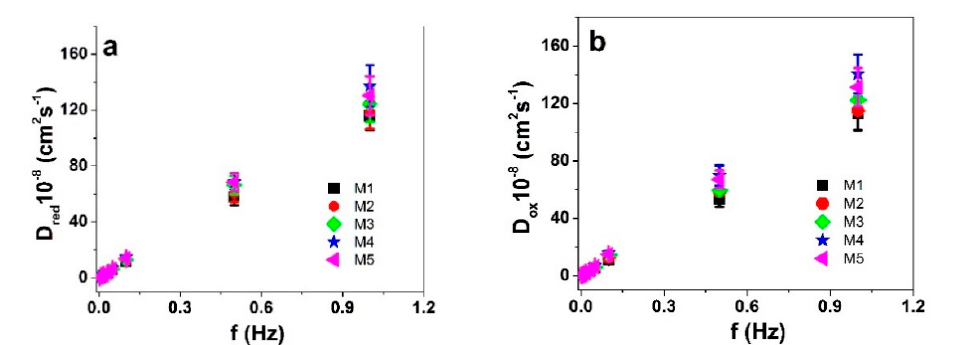
Figure 5. Diffusion coefficients obtained from Equations (2) and (3), from square wave potential step measurements in LiTFSI-aq electrolyte in a potential range of ± 0.7 V. From the membrane actuators M1 ( ■ ), M2 ( ● ), M3 ( ♦ ), M4 ( ★ ) and M5 ( ◄ ), the diffusion coefficients upon reduction D red are shown in ( a ) and those upon oxidation D ox are presented in ( b ) against the applied frequency f.